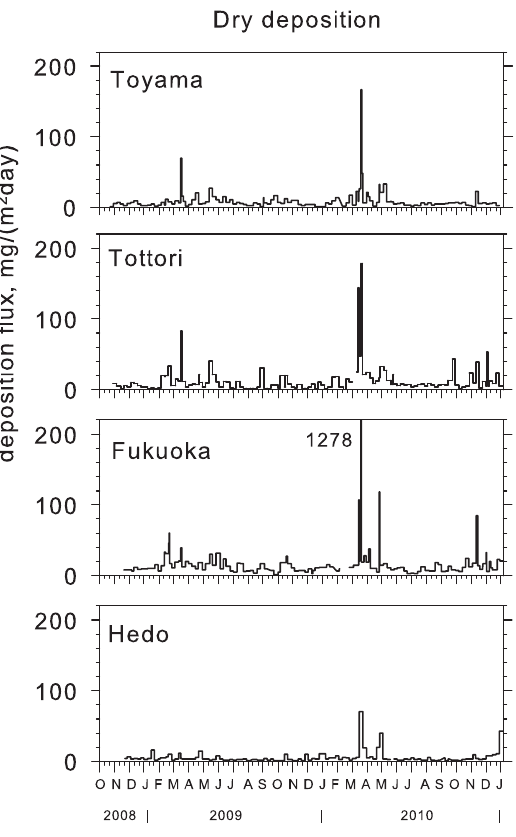
Fig. 4. Dry deposition flux (mgm − 2 day − 1 ) of mineral dust